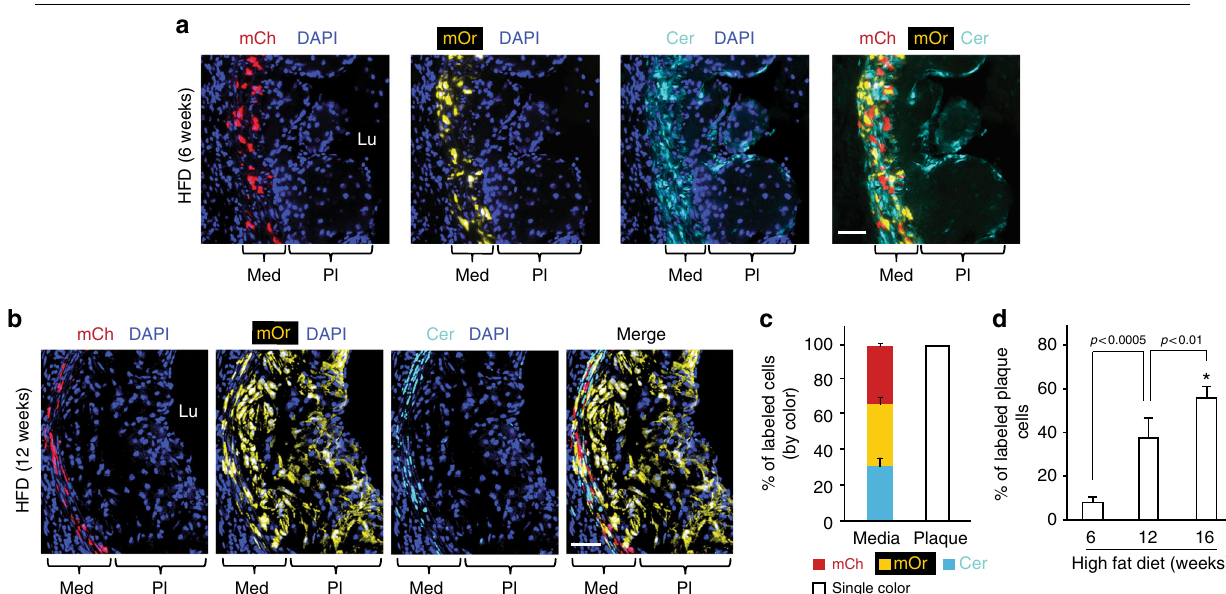
Fig. 2 A single SMC gives rise to most of the cells in an atherosclerotic plaque. a , b ApoE ( − / − ) , SMMHC - CreER T2 , ROSA26R ( Rb / + ) mice were induced with tamoxifen (1 mg/day for 5 days), rested, fed a high fat diet (HFD) for 6 or 12 weeks as indicated, and transverse aortic root sections were stained with DAPI and directly imaged for the Rb colors (mCherry (mCh), mOrange (mOr), and Cerulean (Cer)). Marked cells in each atherosclerotic plaque are a single color (Cer in a and mOr in b ) indicating that a single SMC gives rise to all smooth muscle-derived plaque cells. Scale bars, 50 μ m. c Quanti fi cation of marked cells by Rb color in aortic root atherosclerotic plaques and adjacent media mice fed a high fat diet for 6, 12, and 16 weeks from sections stained and imaged as in a and b . n = 9 mice (all male), 11 atherosclerotic plaques, 6 sections per plaque were quanti fi ed and the average number of labeled plaque cells scored per plaque by duration of high fat diet: 6 weeks (80 plaque cells), 12 weeks (458), and 16 weeks (936). d Quanti fi cation of the average percent of atherosclerotic plaque cells that are SMC-derived classi fi ed by weeks of high fat feeding. n = 9 mice, 11 plaques. *vs. 6 weeks, p < 0.0001. One-way ANOVA with Tukey ’ s multiple comparisons test was used. Error bars represent standard